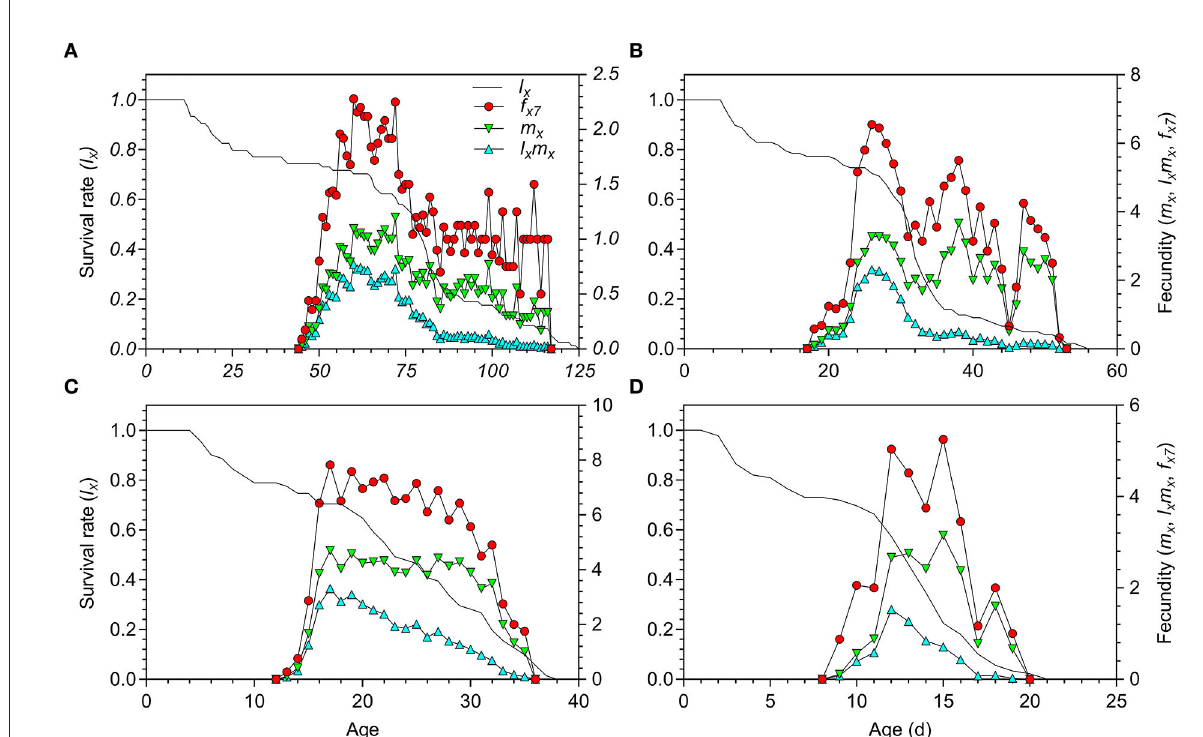
FIGURE2 Age-specific survival rate ( l x ), fecundity ( m x ), net maternity ( l x m x ), and female age-specific fecundity ( f x 7 ) of Orius strigicollis fed on Frankliniella occidentalis under 18.5 ◦ C (A) , 23.5 ◦ C (B) , 27 ◦ C (C) , and 33 ◦ C (D) .